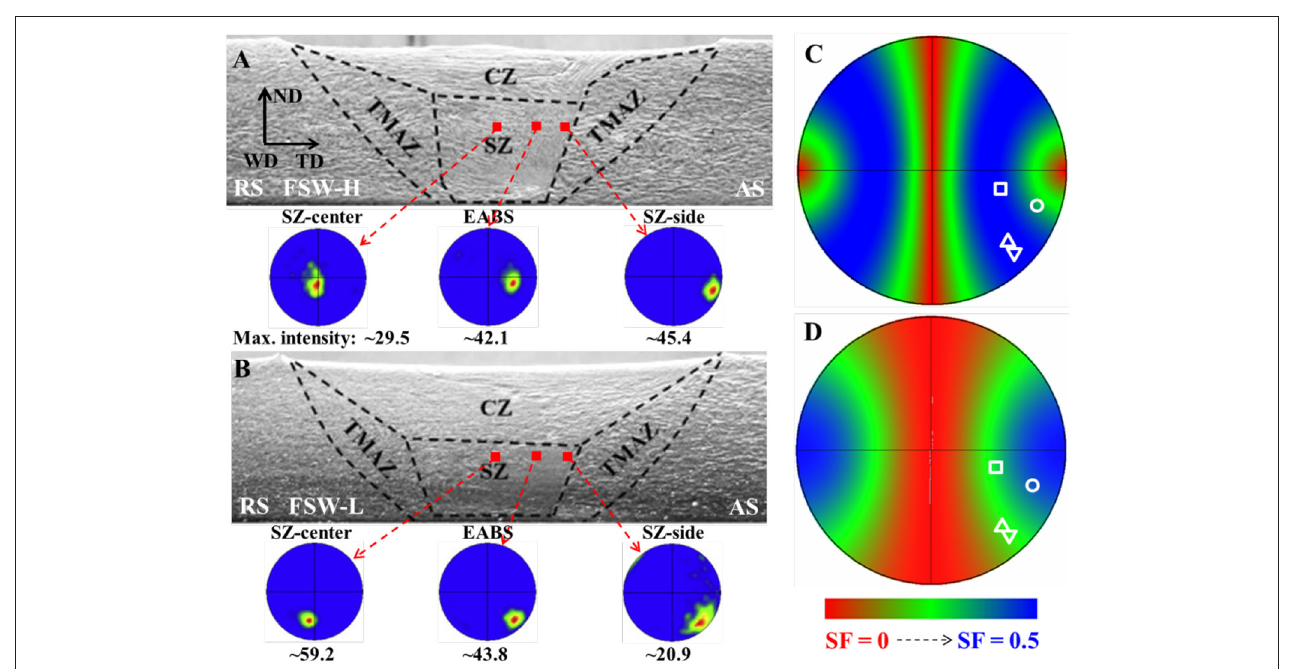
FIGURE 8 | {0001} pole figures for different regions in the SZ of (A) FSW-H joint and (B) FSW-L joint (Xin et al., 2016); (0001) pole figures showing the calculated SF for (C) basal slip and (D) extension twinning. The region close to SZ-side and SZ-side in FSW-H and FSW-L joints are superimposed on the pole figures and indicated by (cid:3) , ◦ , △ , and, ▽ respectively (Copyright © 2016, ELSEVIER BV).